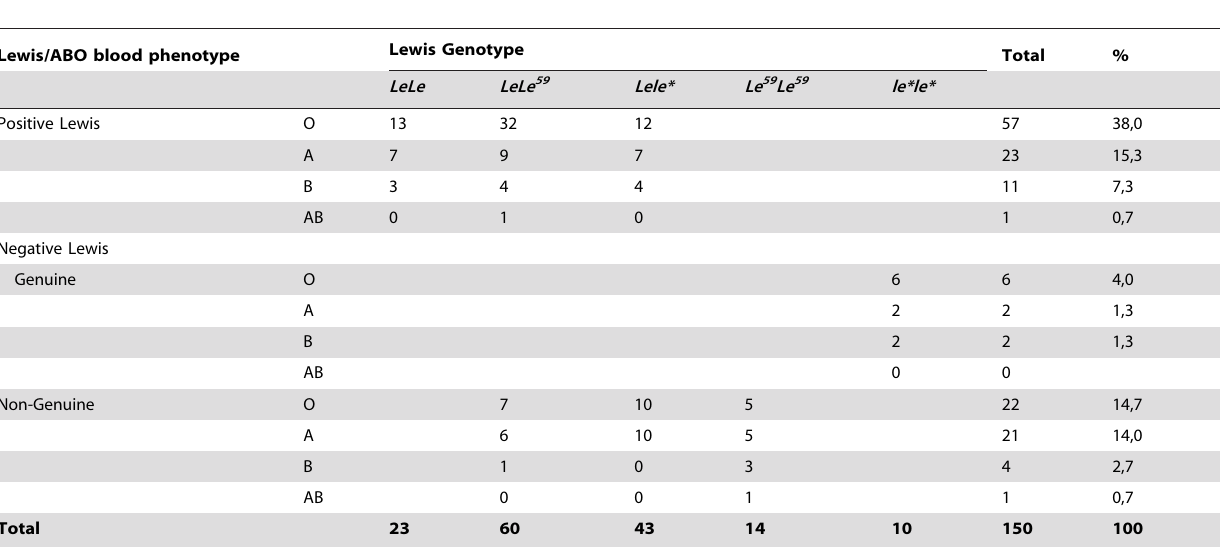
Table 3. Lewis and ABO blood group phenotypes and FUT3 genotypes recorded for the individuals from Bele´m in the northeast Brazilian Amazon region.